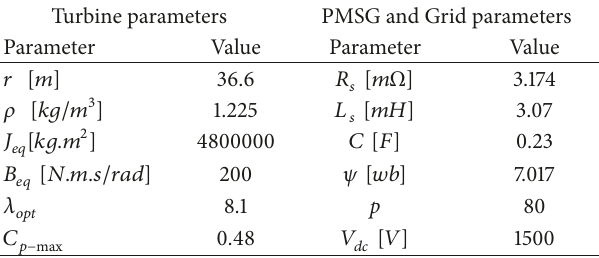
Table 1: The parameters of a 1.5 MW PMSG-based wind turbine and grid characteristics.